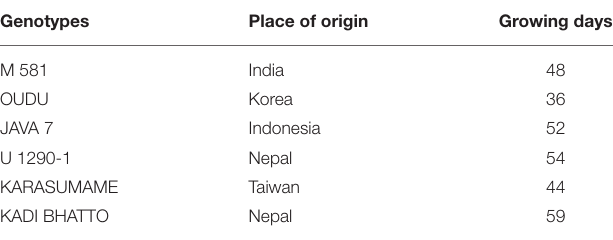
TABLE 1 | Details of the soybean root dataset used in the experiment.